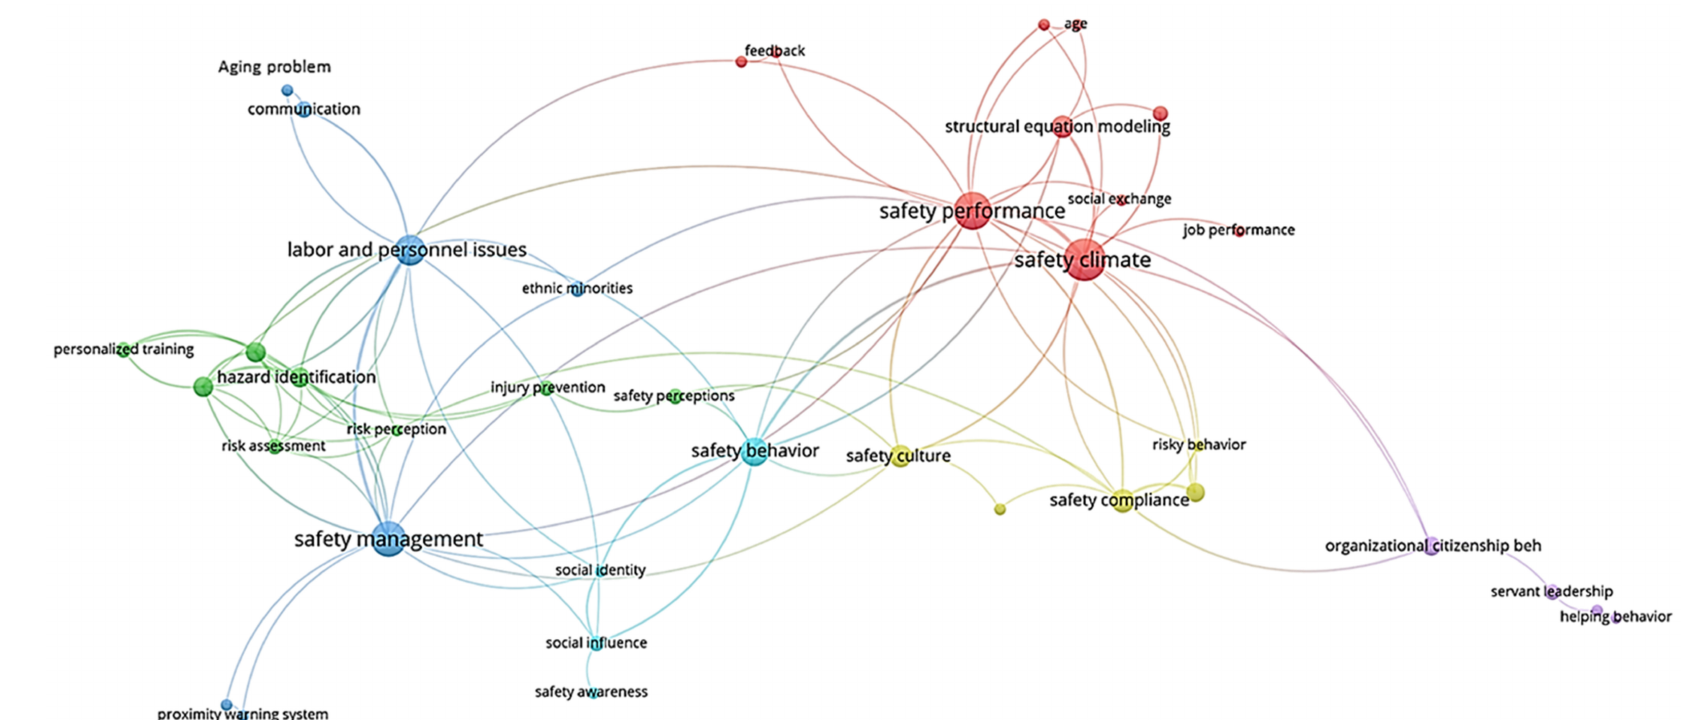
Figure 5. Co-occurrence network for author keywords of collected